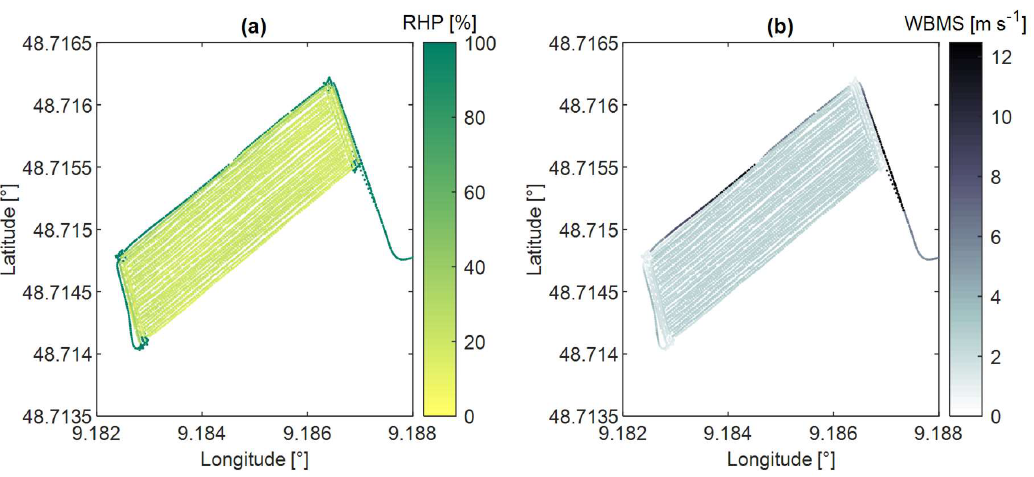
Figure 5. Acquired data for: ( a ) rear hitch position (RHP) signals; and ( b ) wheel-based machine speed (WBMS) signals. (WBMS)